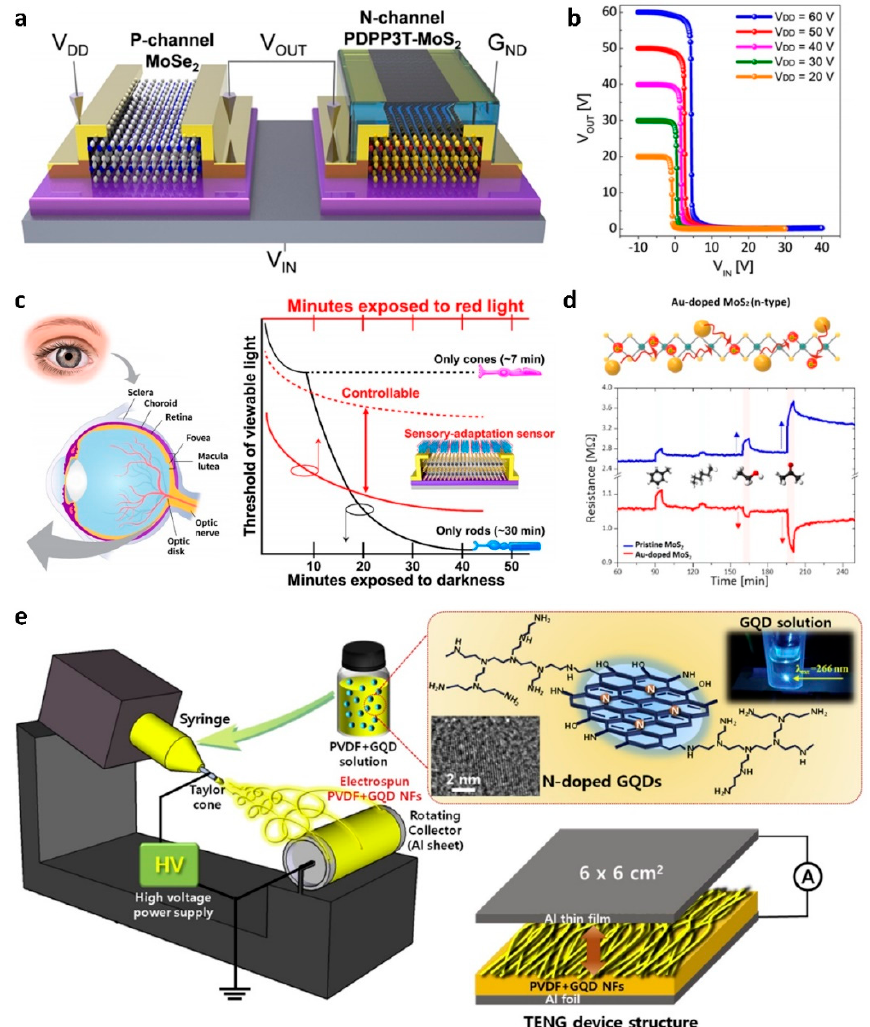
Figure 8. ( a ) Schematic of complementary metal-oxide-semiconductor (CMOS) inverter using doped-MoS 2 and MoSe 2 transistors (adapted from [94] with permission from ACS publications). ( b ) Transfer curves of CMOS inverter using doped-MoS 2 and MoSe 2 transistors (adapted from [94] with permission from ACS publications). ( c ) Sensory adaptation of the eye and CsPb(Br 0.5 I 0.5 ) 3 − MoS 2 phototransistor (adapted from [89] with permission from ACS publications). ( d ) Real-time resistances of pristine MoS 2 and Au-doped MoS 2 sensors exposed to various VOCs (adapted from [109] with per- mission from ACS publications). ( e ) Triboelectric nanogenerator using n-doped graphene quantum dots and polyvinylidenefluoride (PVDF) (adapted from [110] with permission from